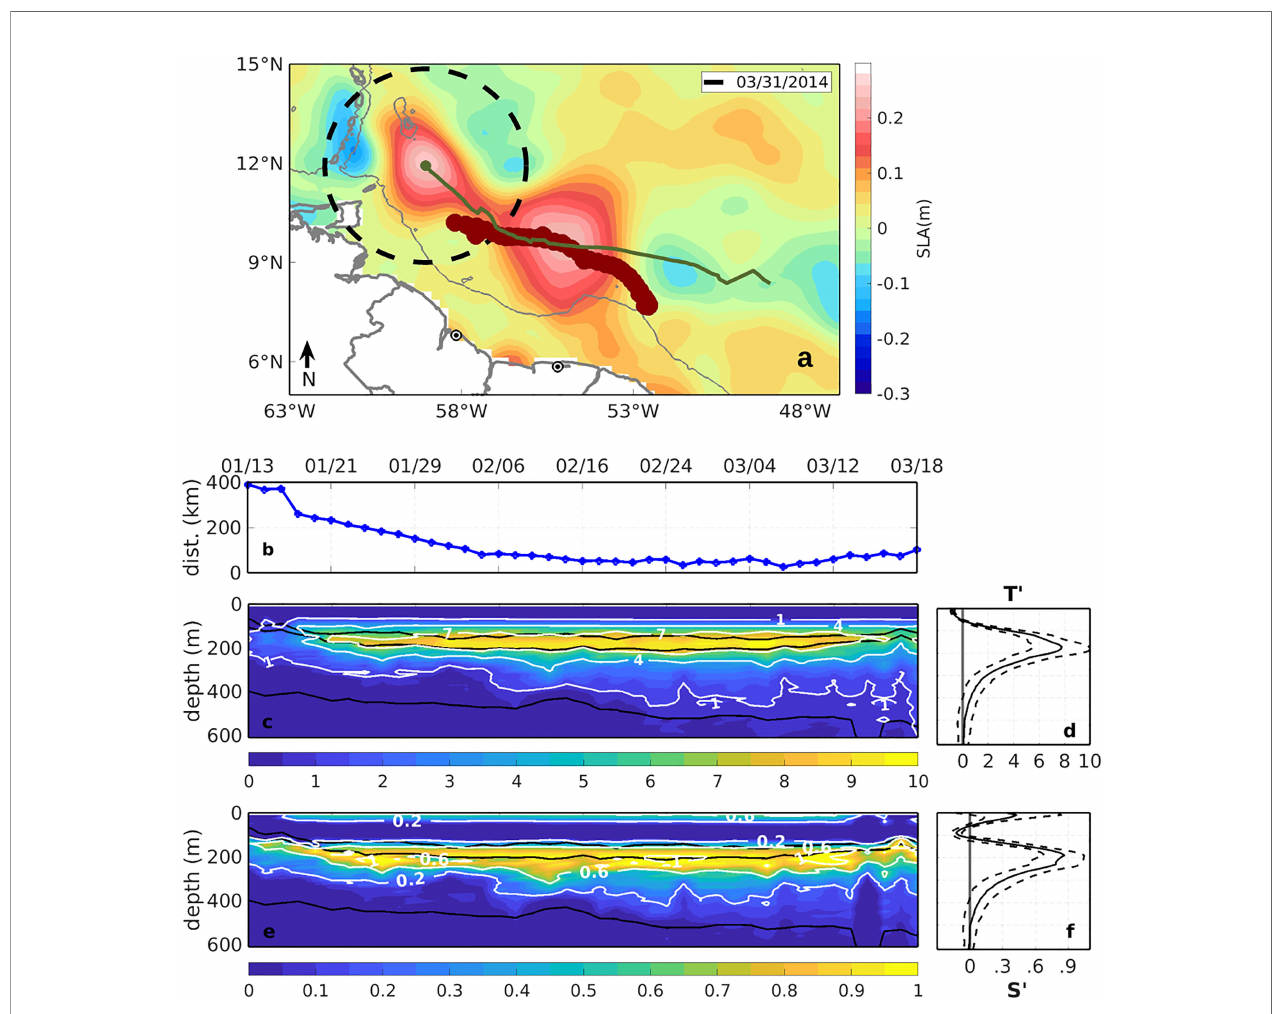
FIGURE 11 | Ring B seen as a positive sea level anomaly at the end of its recorded trajectory in the META dataset in (A) . The green line is the ring trajectory, the dashed circle corresponds to twice the ring radius (2R), and the brown markers are the locations of the IR pro fi les from ARGO. The distances from the ring center to the ARGO pro fi les is shown in panel (B) . The T and S anomalies with respect to the ring exterior (OR pro fi les) are presented in panels (C, E) together with the 24.5, 25.5 and 27.1 kgm - ³ isopycnals (black lines, from top to bottom); and their time average (plus and minus one standard deviation) in panels (D, F) . No smoothing was applied to the ARGO